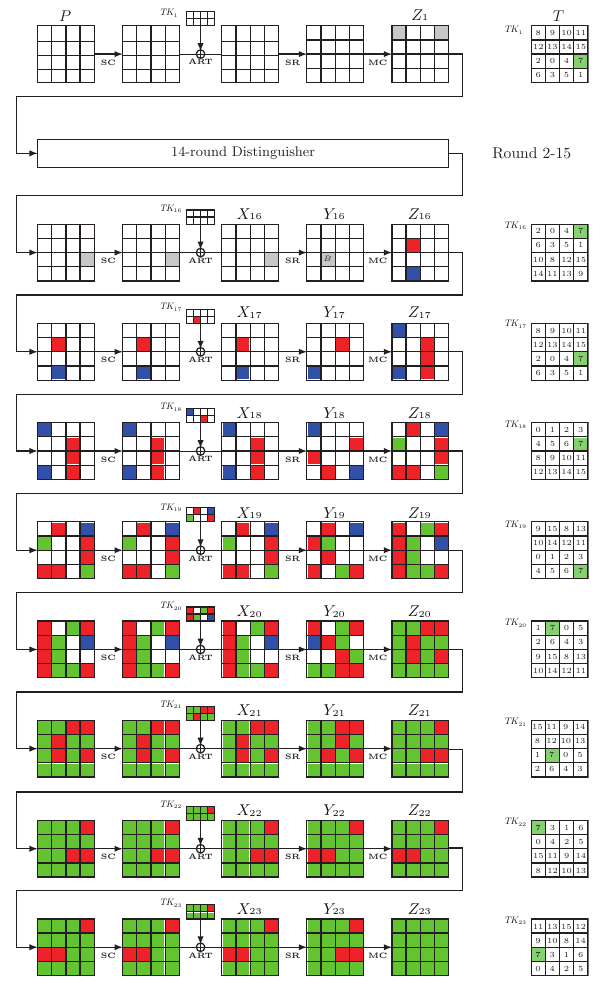
Figure 22: Key-recovery attack on 23-rounds of Skinny